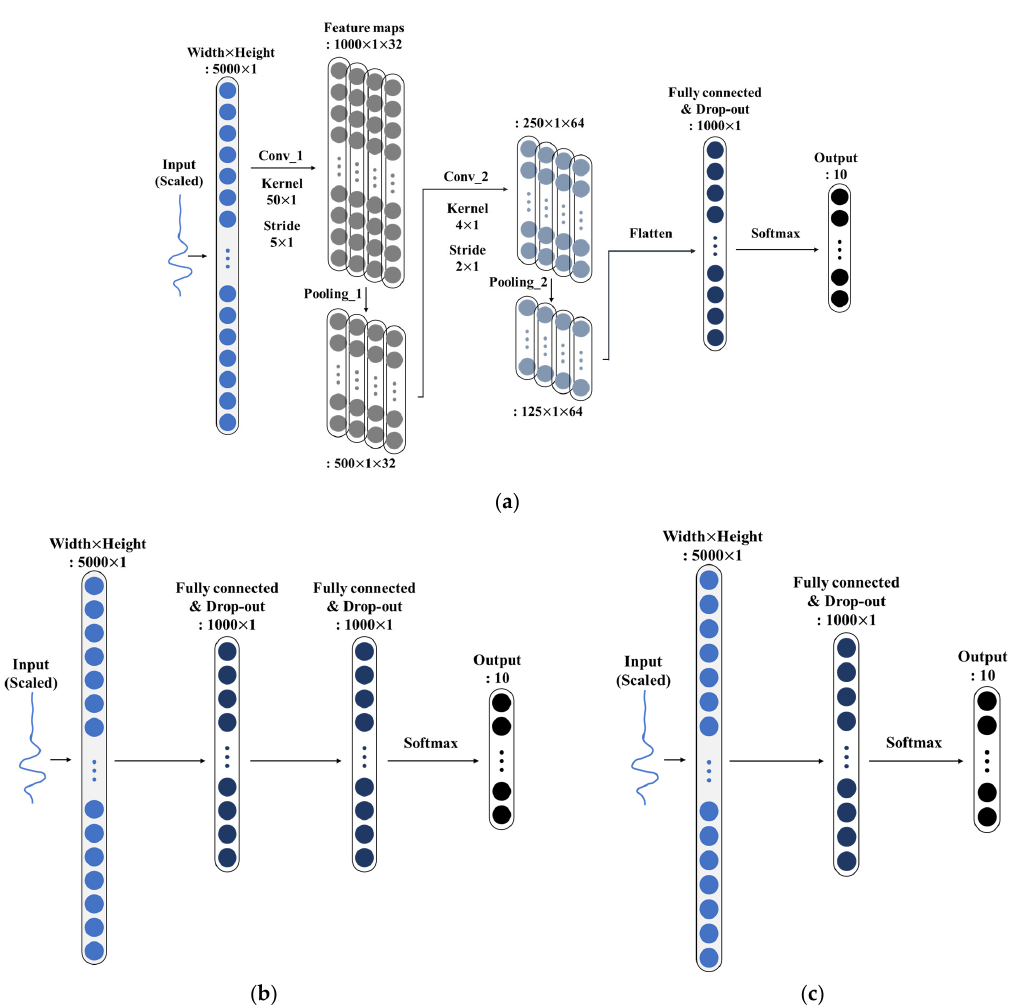
Figure 6. Architectures of the ( a ) convolutional neural network (CNN), ( b ) deep neural network (DNN), and ( c ) multi-layer perceptron (MLP) models. Table 4. Parameters used to train each model.